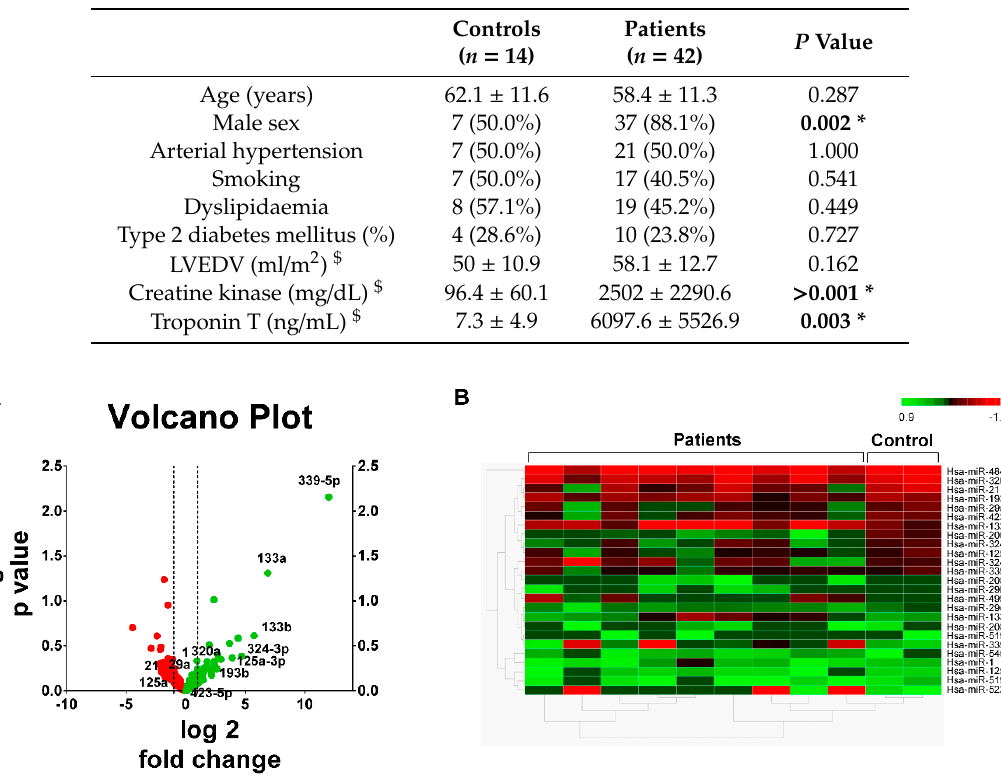
Table 1. Demographic and clinical characteristics of STEMI patients ( n = 42) and controls ( n = 14). Data are shown as the means ± SEM and as n (%). Student’s t-tests were performed. LVEDV stands for the left ventricular end-diastolic volume; (*) indicates p < 0.05, which is considered statistically significant; $ indicates that the variable was examined at admission.